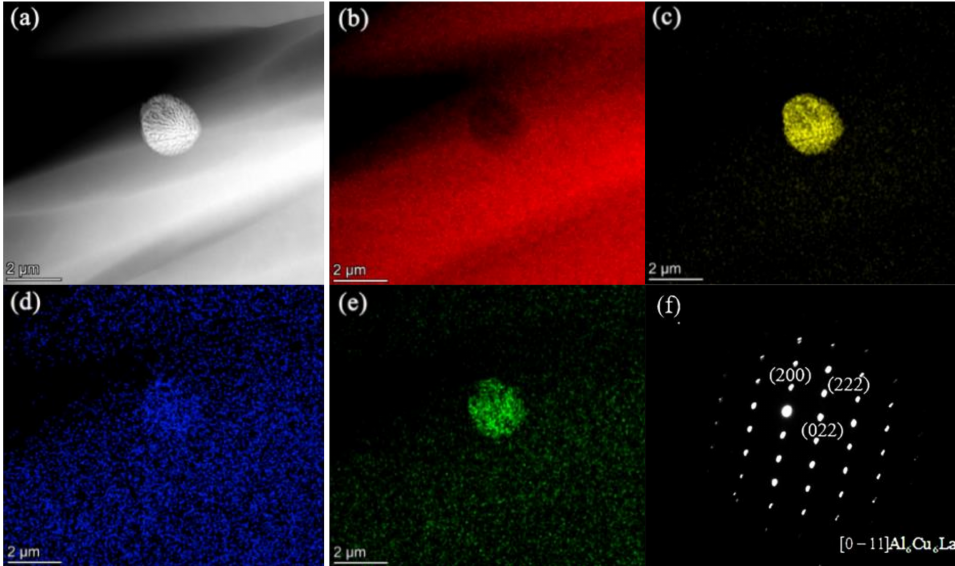
Figure 4. ( a ) TEM image, elemental maps of ( b ) Al, ( c ) Cu, ( d ) Ti, and ( e ) La and (f) selected area electron diffraction pattern in the zone axis of [0–11]Al 6 Cu 6 La of the particles consisted of Al, Cu, and La in Al-2Cu alloy by adding 0.4% Al-5Ti-1B + 0.08% La.